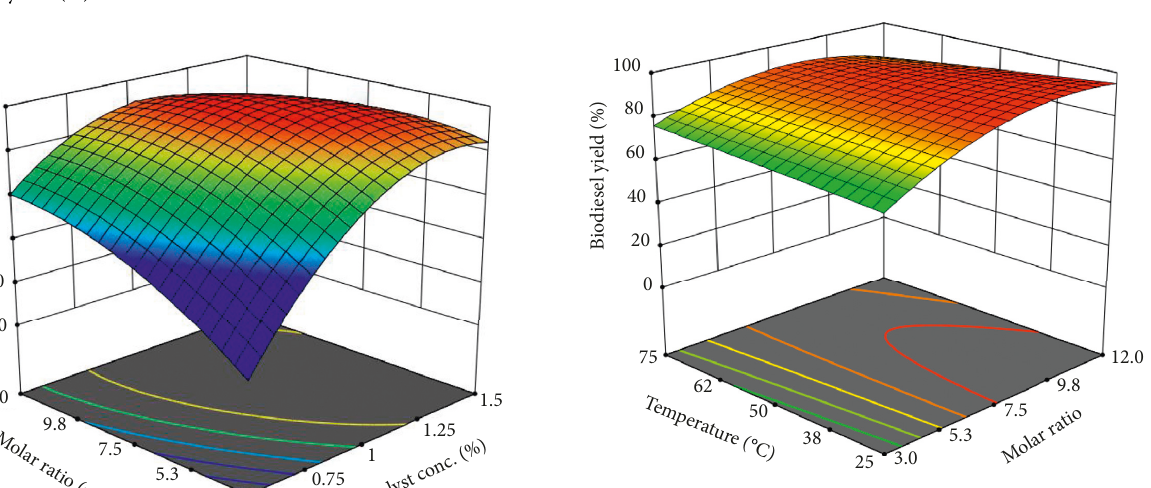
Figure 4: Effect of reaction temperature, ethanol to mixed oil molar ratio, and their combined interaction on the yield of bio- diesel at a catalyst concentration of